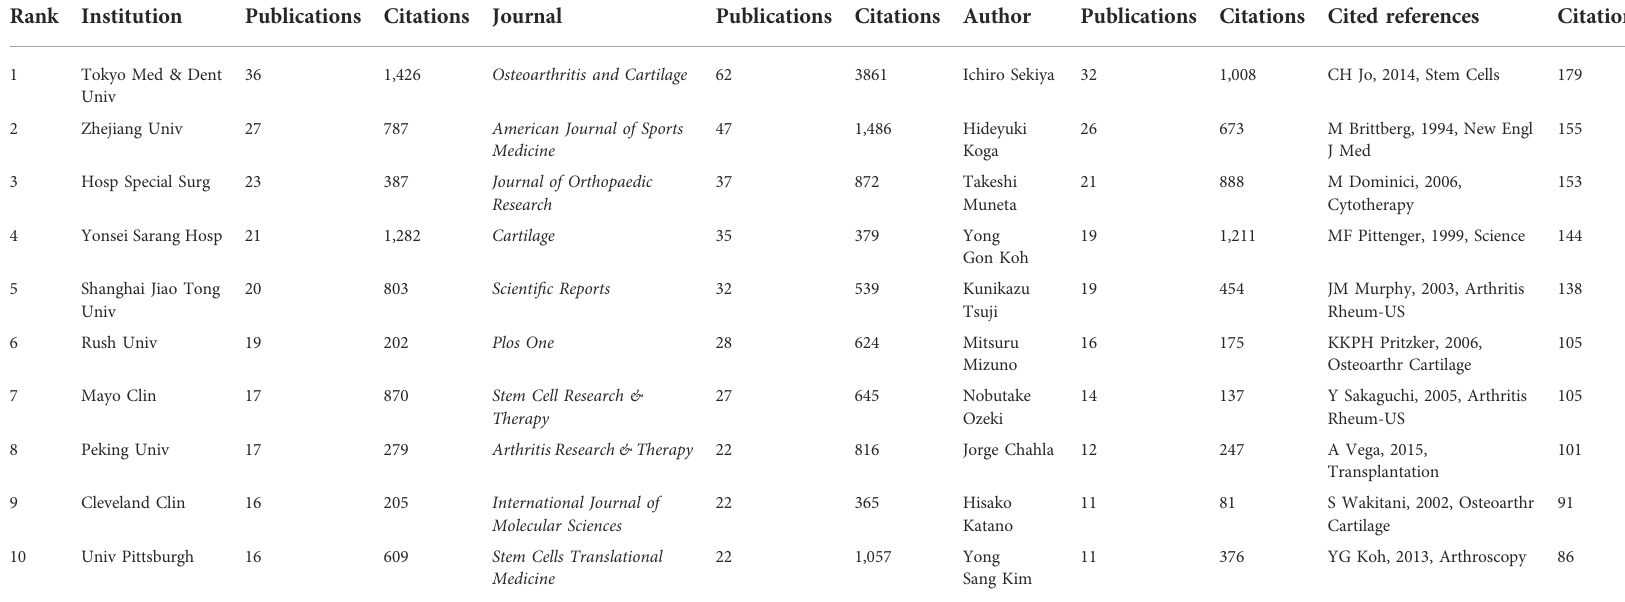
TABLE 2 Top 10 institutions, journals, authors of publications, and reference articles on stem cell therapy for KOA. Rank